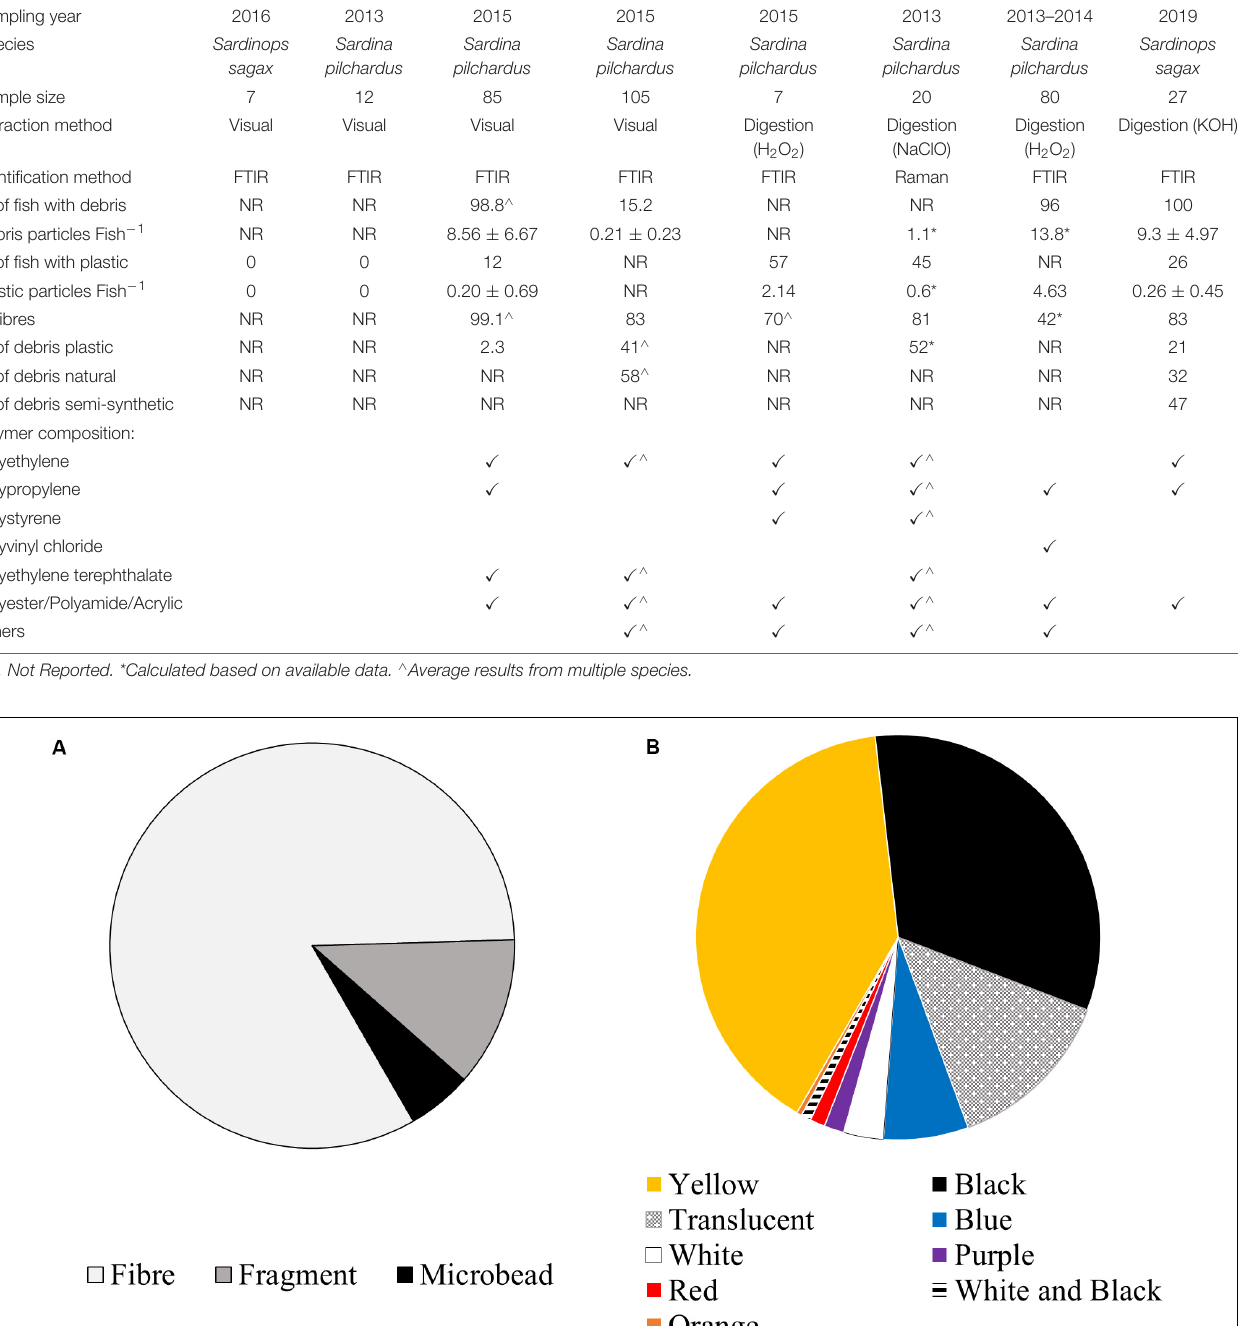
Frontiers in Marine Science |